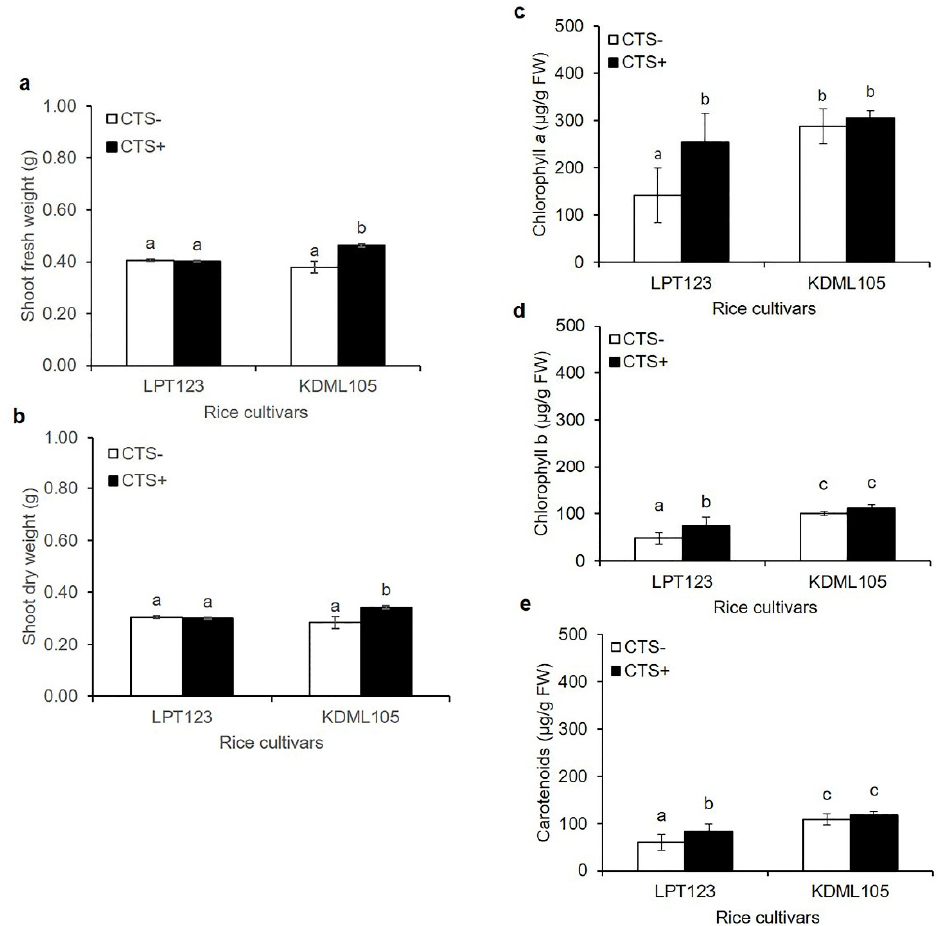
Figure 1. The effects of CTS treatment on seeds and seedlings of the LPT123 and KDML105 rice cultivars treated with and without CTS under osmotic stress for seven days showed shoot fresh weight ( a ) shoot dry weight; ( b ) chlorophyll a ; ( c ) chlorophyll b ; ( d ) and carotenoids; ( e ). Data are represented as mean ± SD, derived from 4 independent repeats. Different lowercase letters indicate significant differences, p < 0.05, ANOVA followed by Duncan ʹ s multiple range test (DMRT).